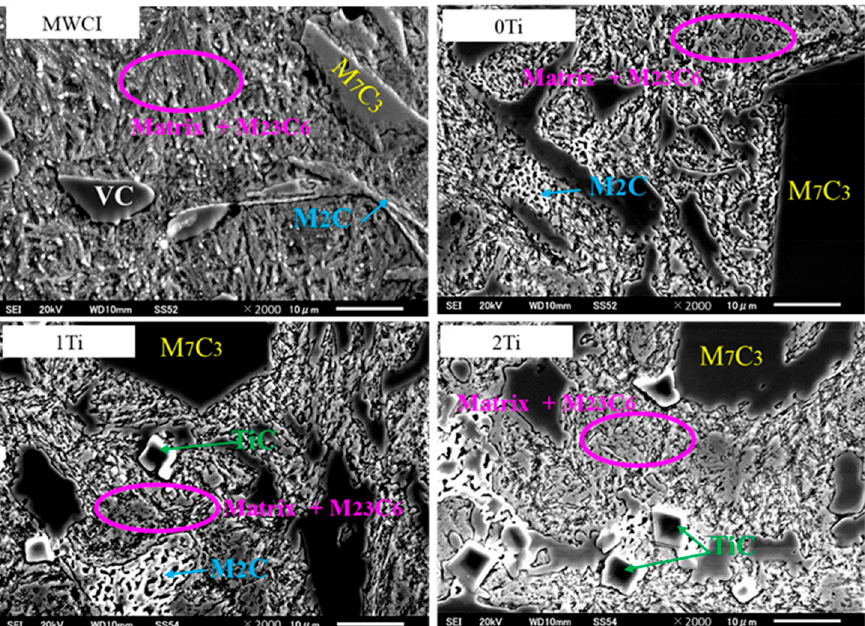
Figure 6. Matrix and secondary-carbide observation through high magnification via SEM.